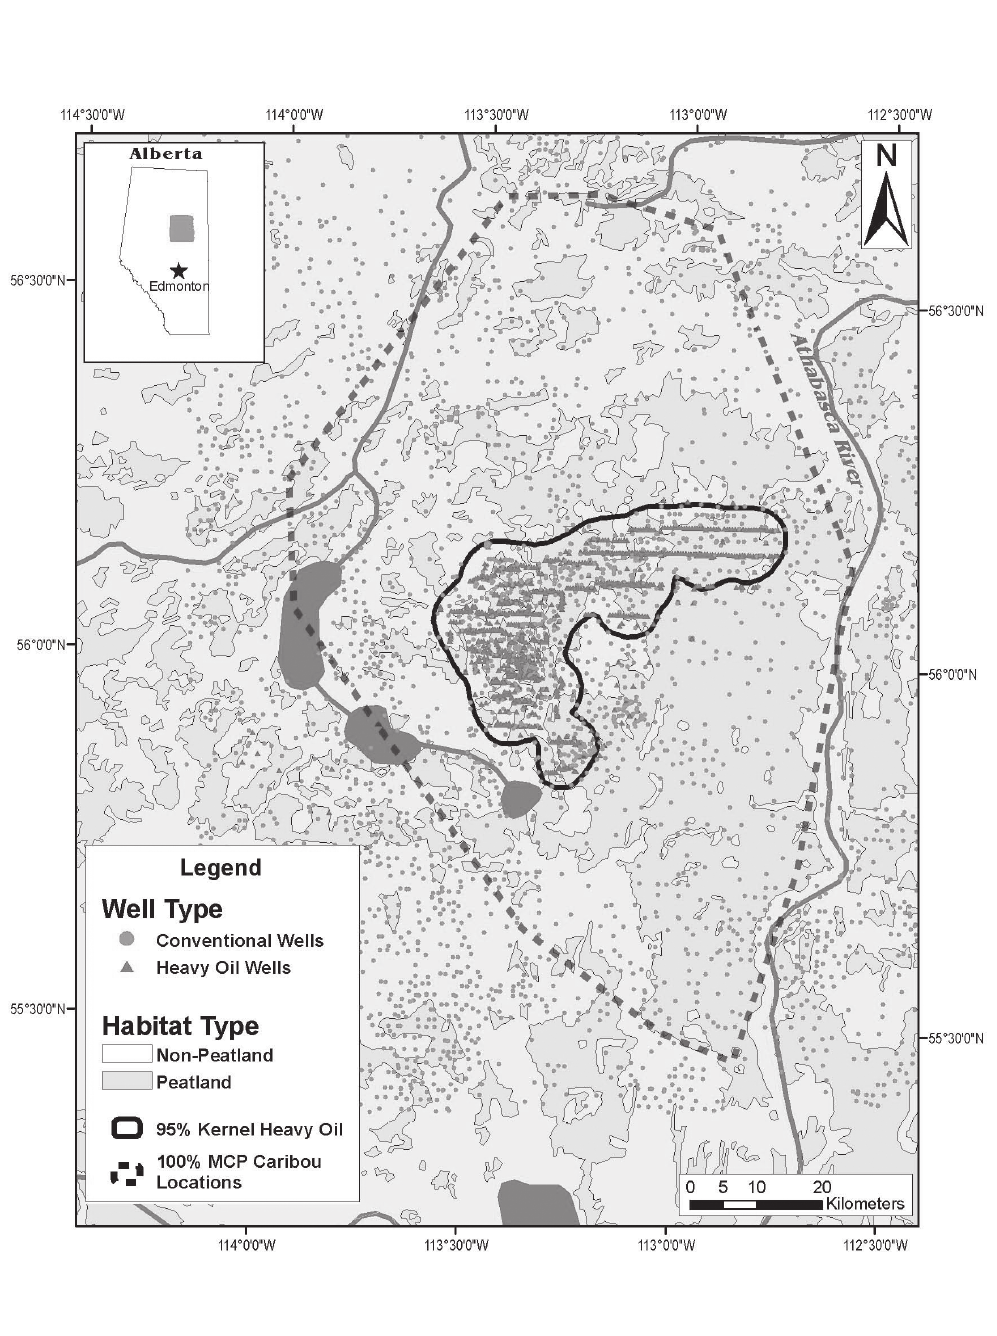
Fig. 1. Map of study area in located northeastern Alberta, with dashed polygon (100% Minimum Convex Polygon) indicating the extent of all woodland caribou locations from the West Side Athabasca River Cari- bou Range (WSAR). Peatland is shown in dark gray and non-peatland in light gray (Peatland Inventory of Alberta, Vitt et al ., 1998). Major rivers are also shown. The locations of all wells in the Alberta Energy and Utilities Board dataset to 2000 are shown. The 95% kernel of most intense petroleum sector development (heavy oil wells) is highlighted. Wells are not shown to